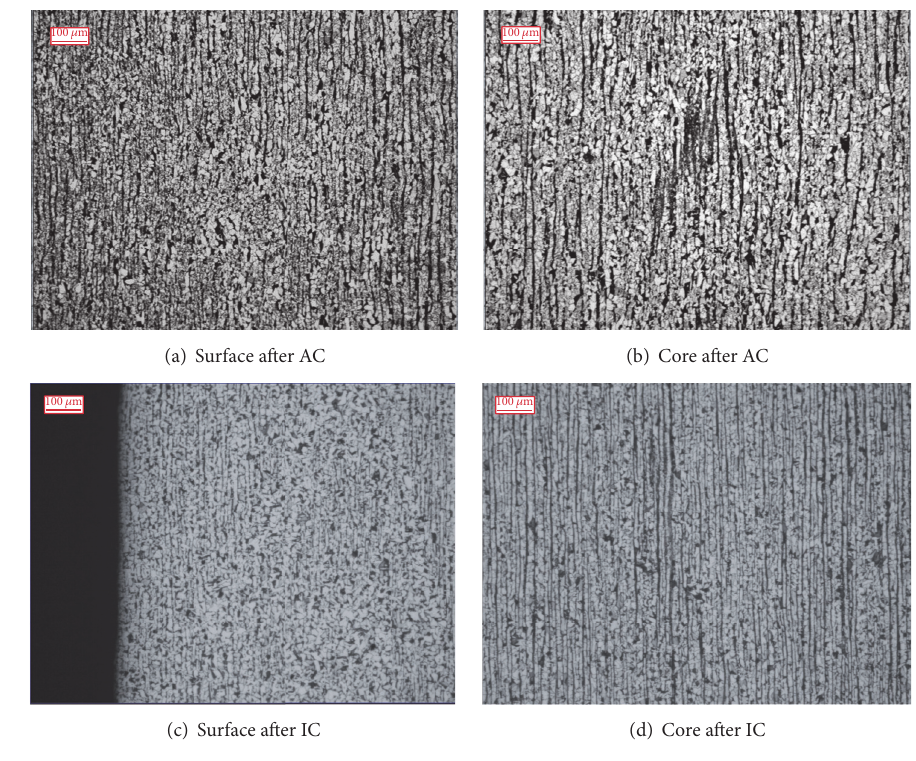
Figure 7: Microstructure of Q345 steel after AC and IC.